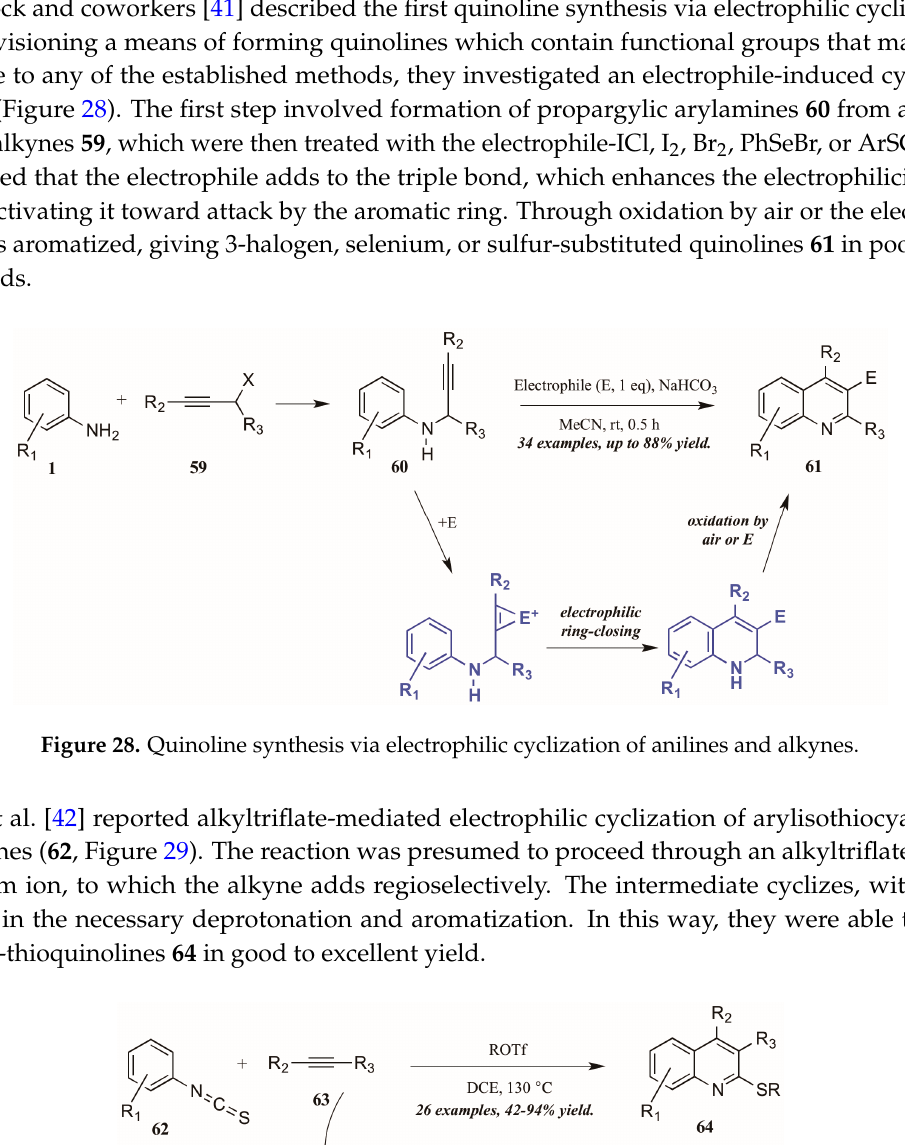
Figure 30. Photochemical electrophilic cyclization to form highly functionalized quinolines.